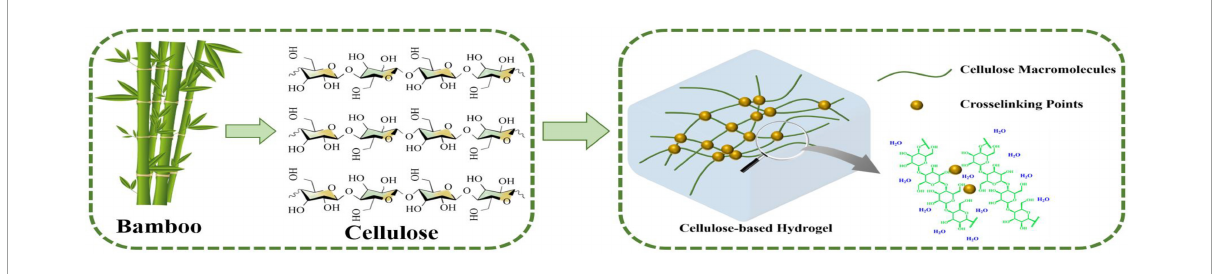
FIGURE1 Schematic illustration of the structures of cellulose and cellulose-based hydrogels as well as the preparation process of cellulose-based hydrogels.